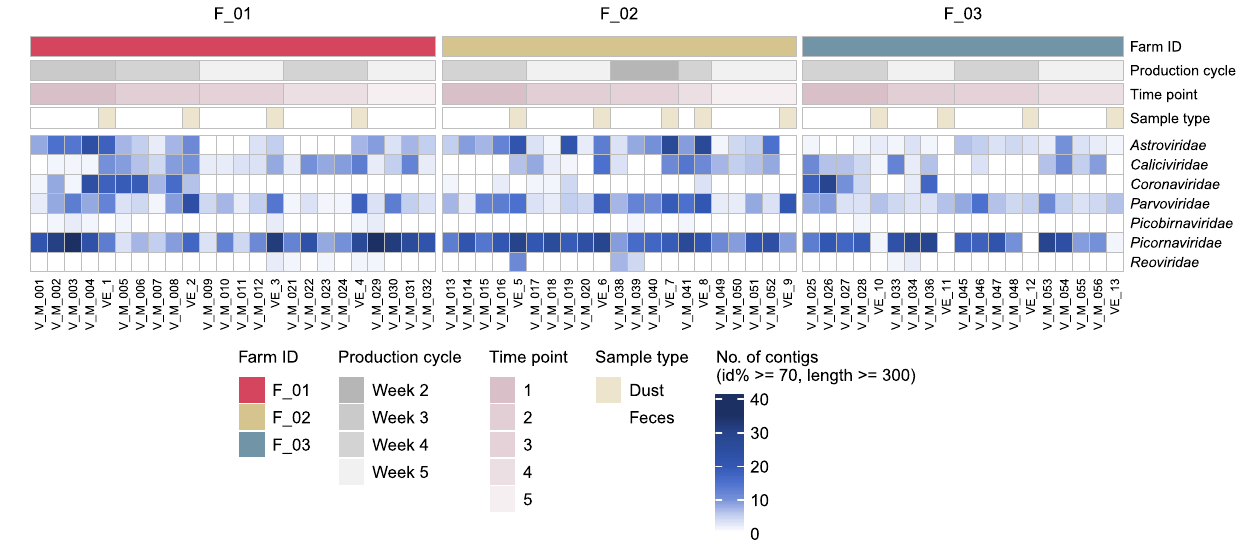
Figure 2. An overview of virus contigs detected in chicken feces and chicken farm dust samples. Each column represents one sample. Associated metadata is shown at the top panel. The color intensity of the heatmap (bottom panel) is determined by number of contigs with minimum length of 300 nt/bp, at least 70% identity and an e-value threshold of 1 × 10 –10 when comparing with closest reference in our database. Sample order is assorted by farm ID, sampling time point. Time point is an arbitrary number. Samples were collected at the same time and place when both farm ID and time point match.